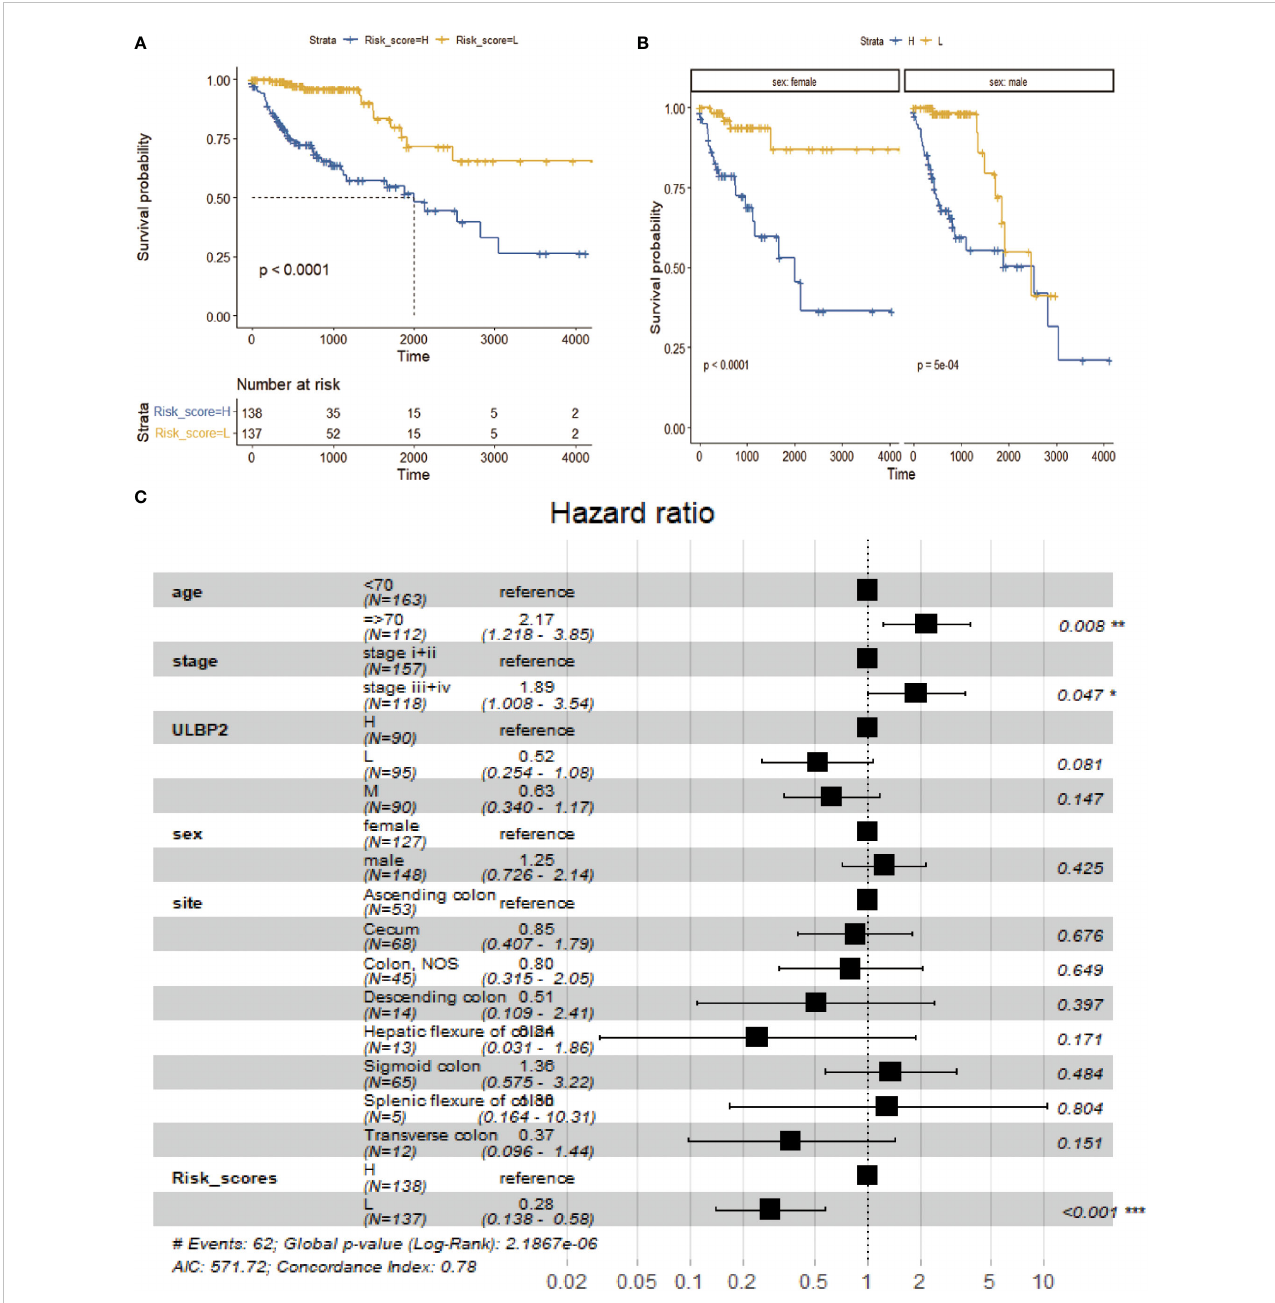
FIGURE 4 Survival analysis between low- and high-risk groups. (A) : Survival analysis of low-risk group vs high-risk group. (B) : Survival analysis of low-risk group vs high-risk group in different sex subgroups. (C) : Survival analysis of multivariate Cox risk